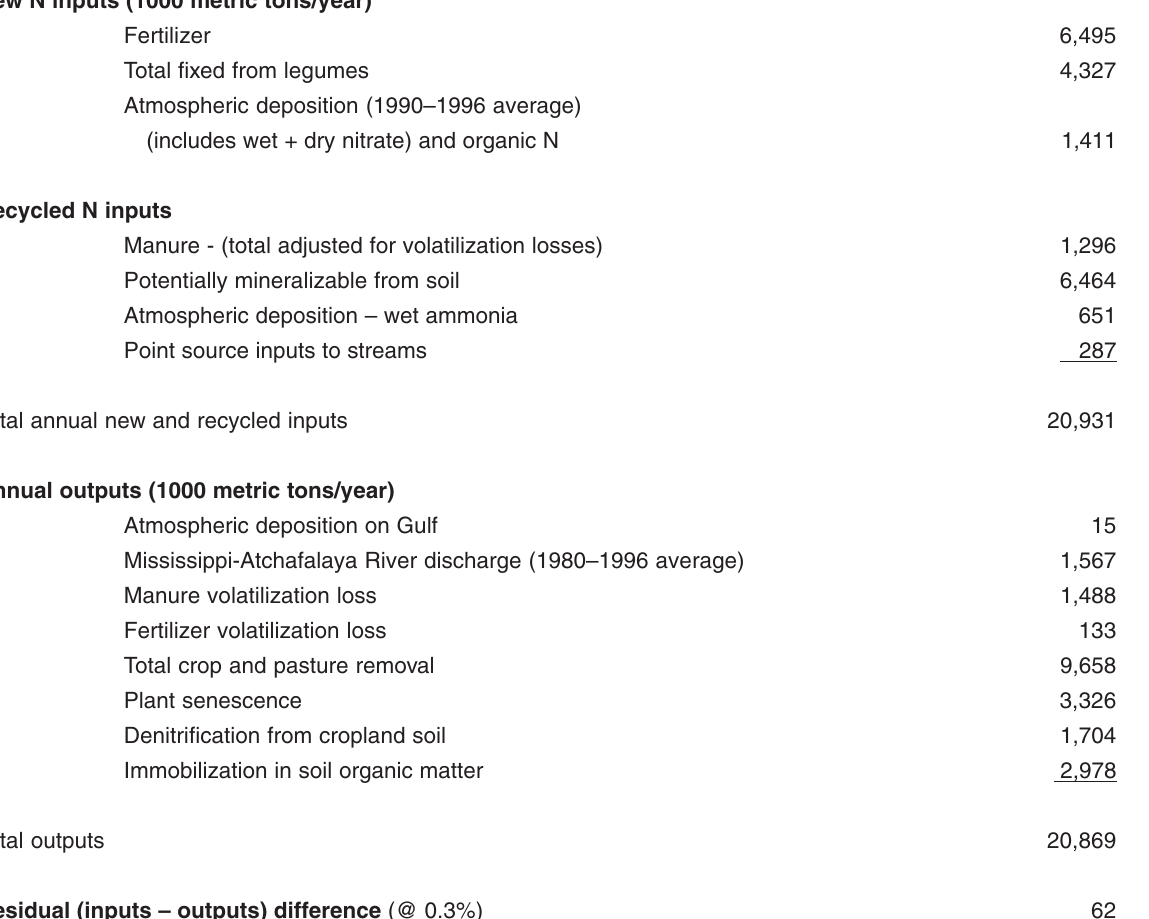
Nitrogen Mass Balance Data for Mississippi-Atchafalaya River Basin for 1980–96, Except as Noted New N inputs (1000 metric